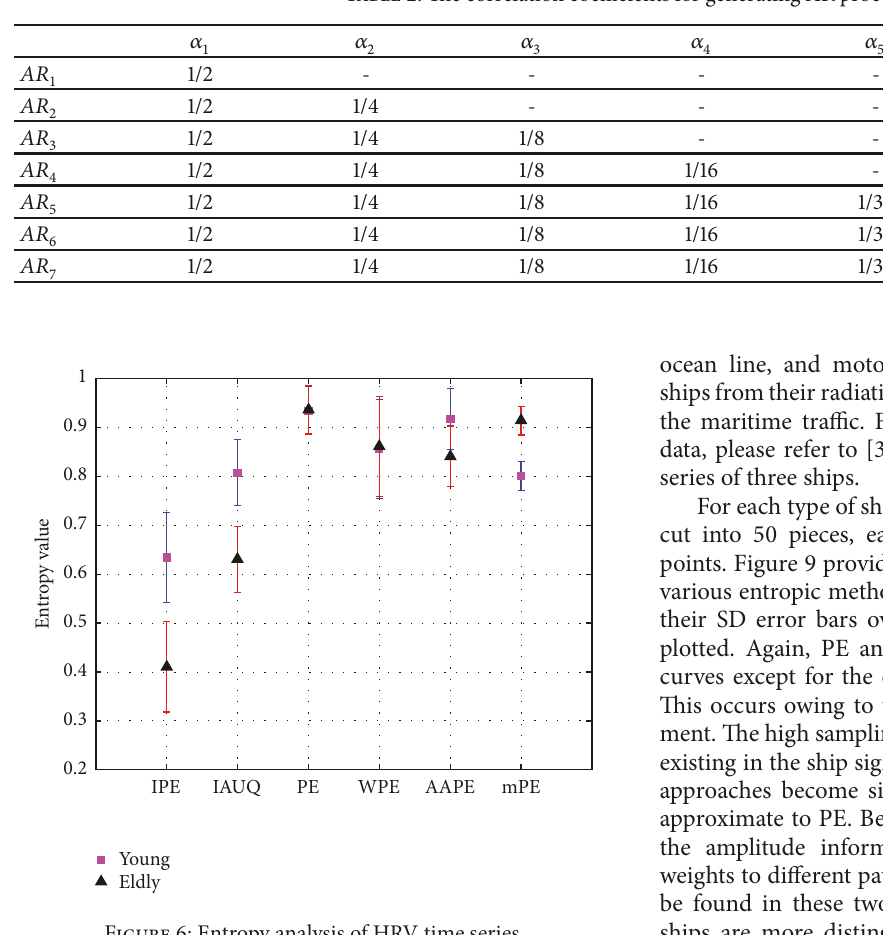
Figure 6: Entropy analysis of HRV time